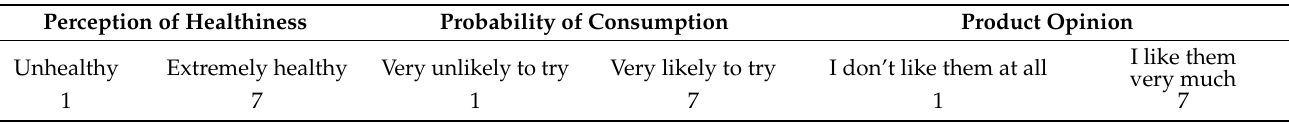
Table 1. Scales used for the evaluation meatball consumption